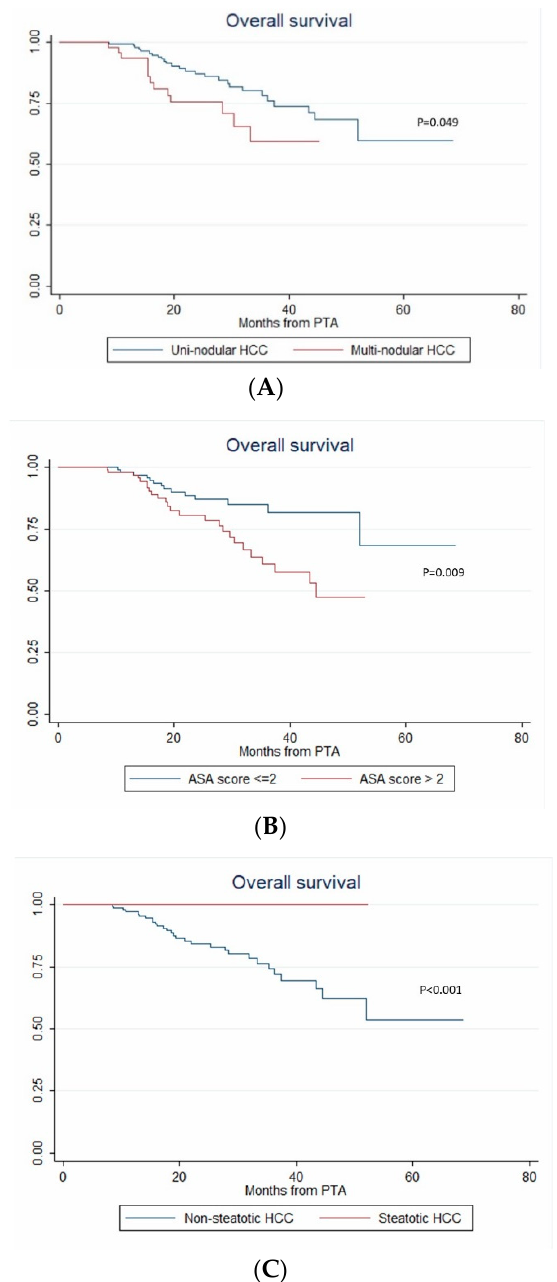
Figure 5. In patients with uninodular vs. multinodular HCC ( A ), with ASA score ≤ 2 vs. >2 ( B ), and with steatotic vs. non-steatotic HCC ( C ) (Kaplan–Meier analyses). Table 4. Univariate and multivariate Cox regression models to predict overall survival (per patient analysis).